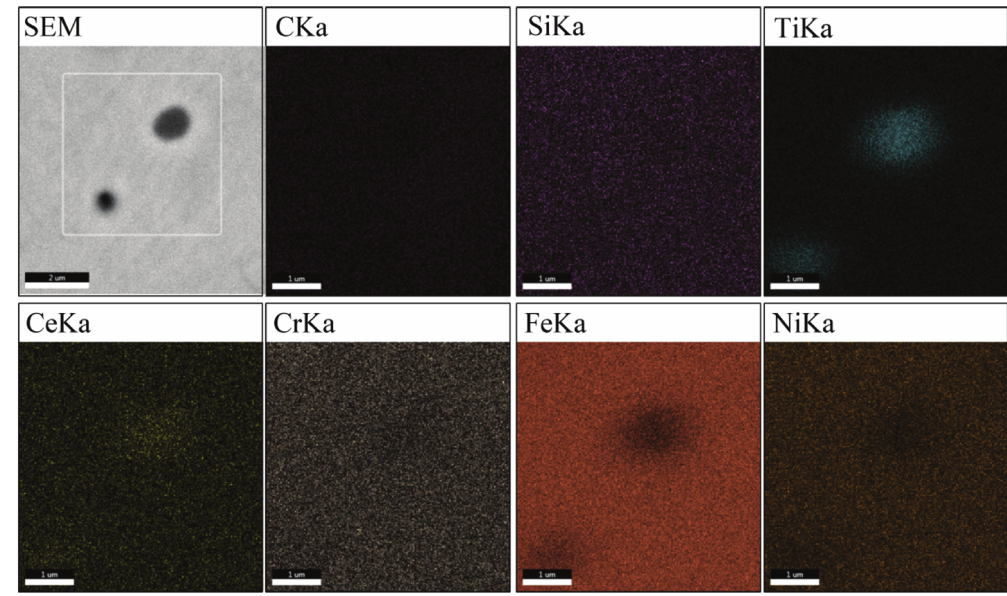
Figure 6: Distribution of elements in the microstructure of A3 cladding layer.